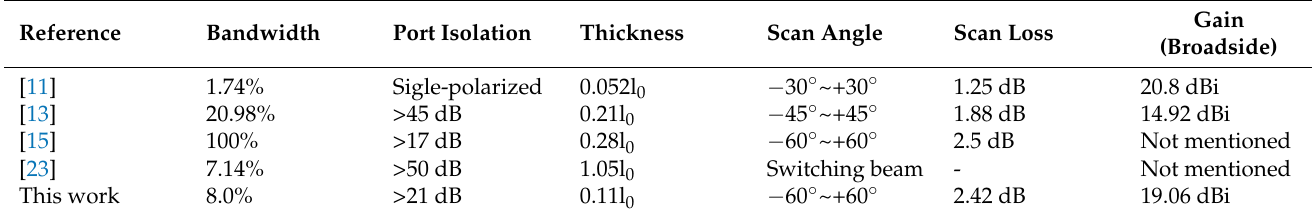
Table 3. Comparison of cylindrical arrays.